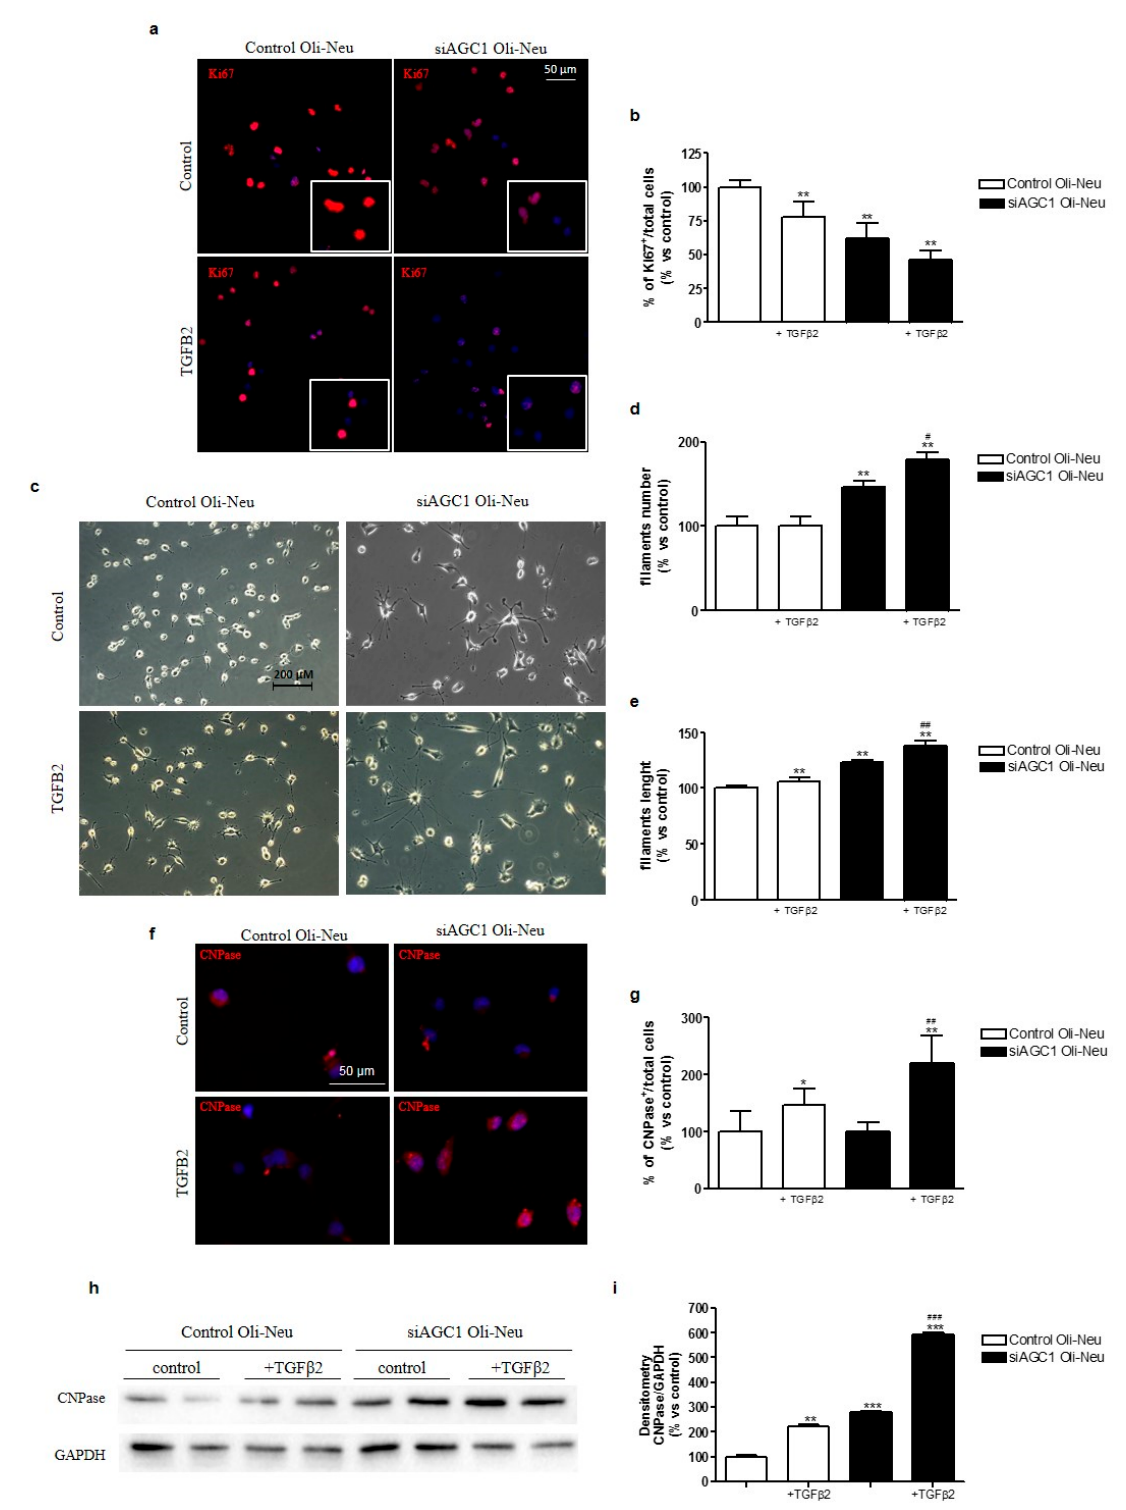
Figure 4. Effects of TGF β 2 treatment on control and AGC1-silenced Oli-Neu cells proliferation and differentiation. Immunofluorescence staining of Ki67 proliferation marker in control and siAGC1 Oli-Neu cells (nuclei were labelled with Hoechst) ( a ) and Ki67 positive-cell count analysis expressed as the ratio of Ki67 positive / Hoechst stained cells ( b ). Optical microscopy images ( c ) of control and siAGC1 Oli-Neu cells untreated and following treatment with TGF β 2. Scale bar: 200 µ m. Filament number ( d ) and filament length ( e ) calculated by using Fiji ImageJ2 software (developed by the National Institutes of Health, NIH, USA). Immunofluorescence analysis of CNPase-positive cells (red, with Hoechst-labelled nuclei in blue) ( f ) and CNPase-positive cell count analysis respectively ( g ).